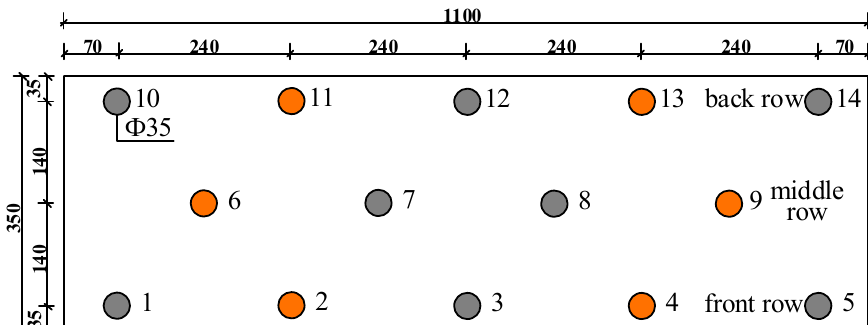
Figure 7. Layout plan of micropiles (unit: mm).